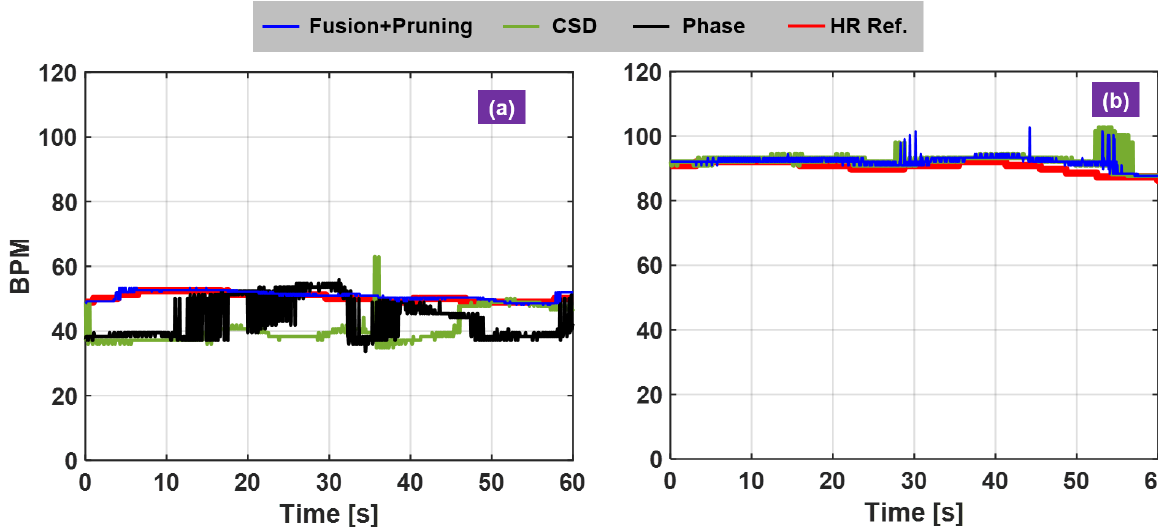
Figure 9. Investigation of heartbeat dynamics on HR monitoring. ( a ) low resting HR; ( b ) high resting